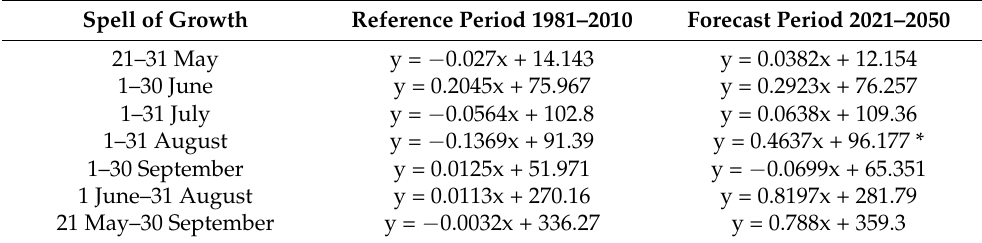
Table 3. Time trend equations of the water needs (mm) of giant miscanthus during its specific spells of growth in the reference and forecast